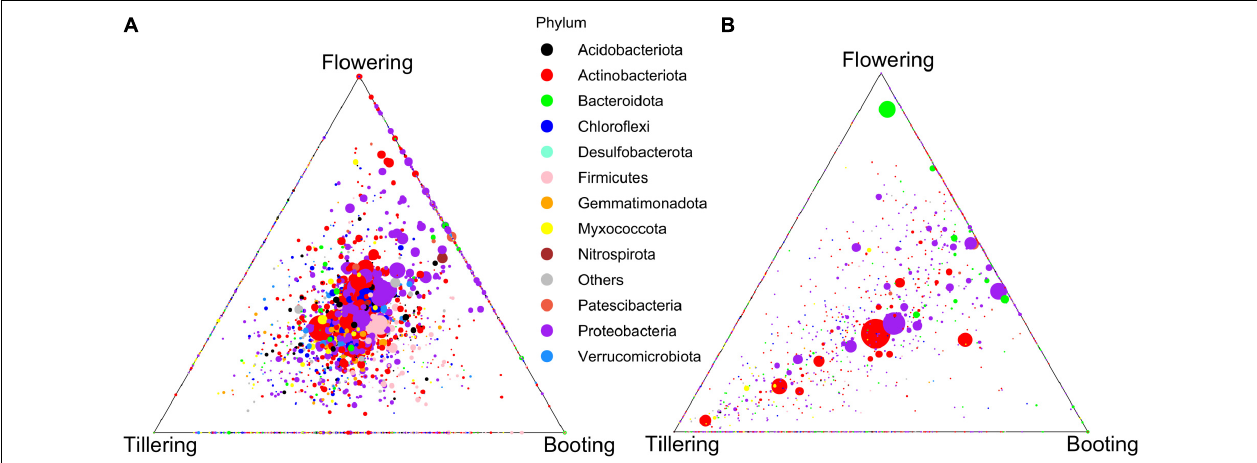
FIGURE 5 | Ternary plot of the ASVs distribution across plant growth stages in the rhizosphere (A) and in the roots (B) of the control plants.